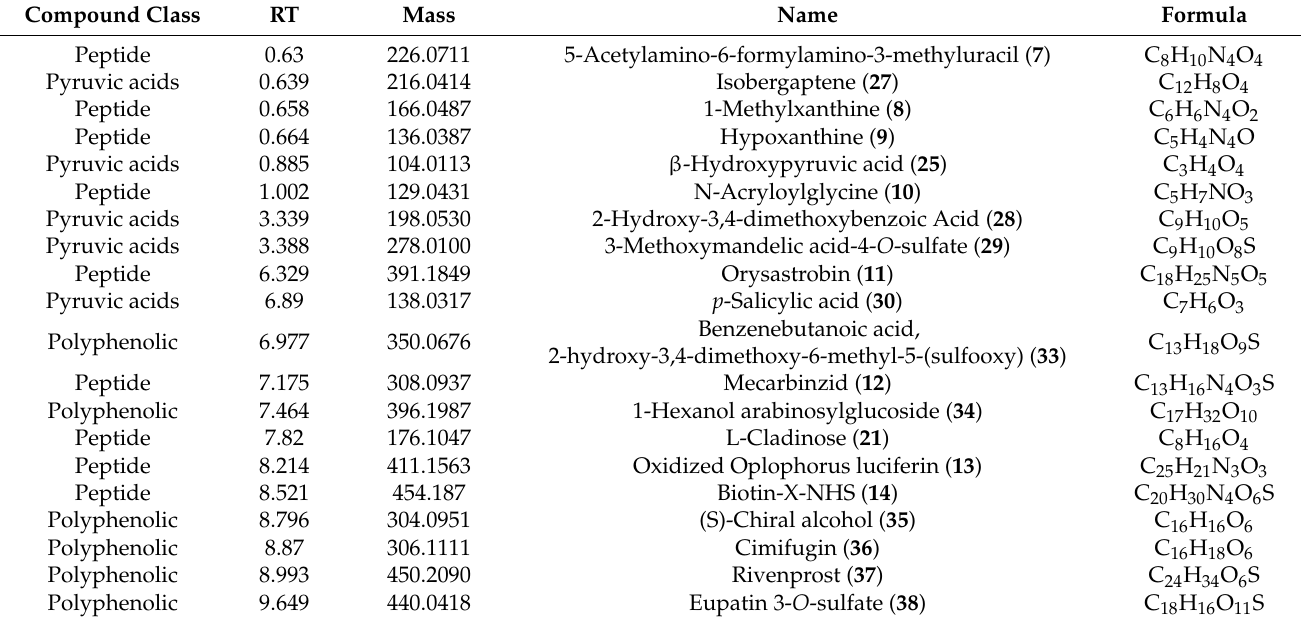
Table 2. Identification of secondary metabolites through UHPLC-Q-TOF-MS (negative mode) from a methanolic extract of H. crispum